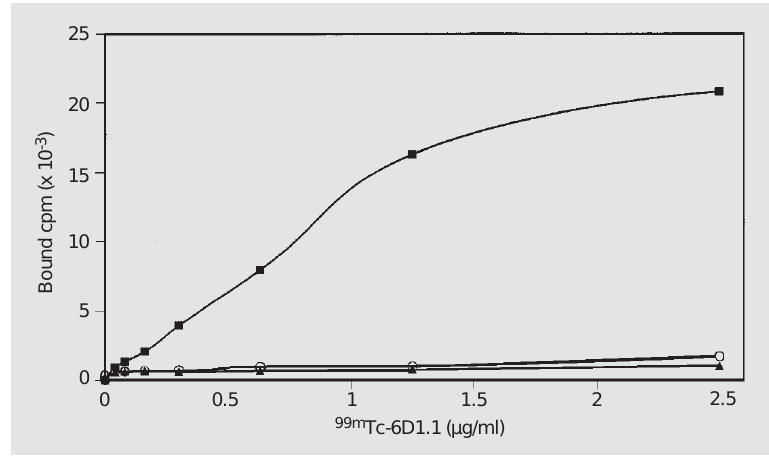
Figure 3 - 99m Tc-6D1.1 binding curves to tumor cell lines: LS-174T (CEA positive), without (squares) and with (circles) prior to incubation with unlabeled antibody, and MeWo (CEA negative;